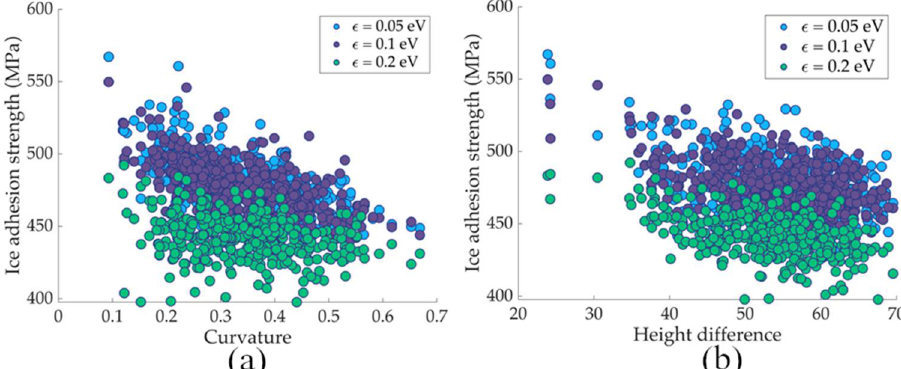
Figure 4. Ice adhesion strength on rough surfaces with varied epsilon values obtained by MD simulations. The same ice adhesion data were plotted against surface curvature ( a ) and height difference ( b ). All the ice adhesion strengths were obtained using a pulling rate of 2 m/s. Each datapoint is an average of 10 independent simulations.